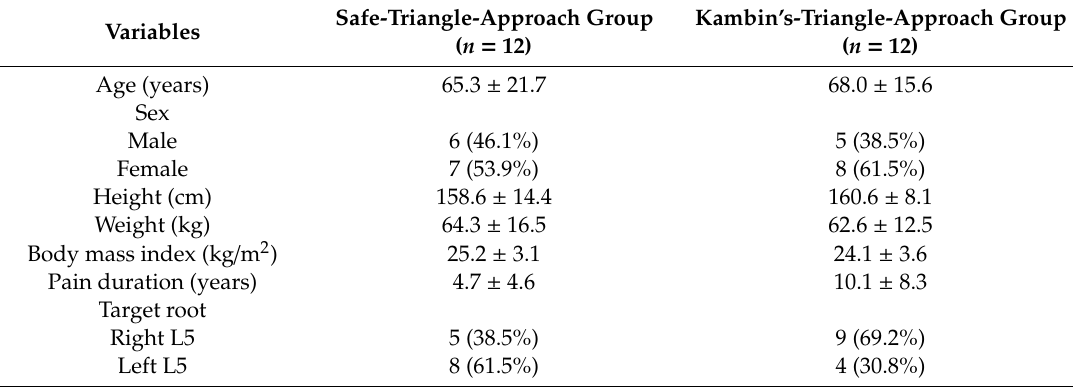
Table 1. Characteristics of the